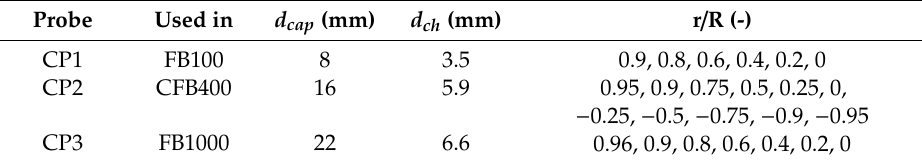
Table 2. Dimensions of the different capacitance probes used.